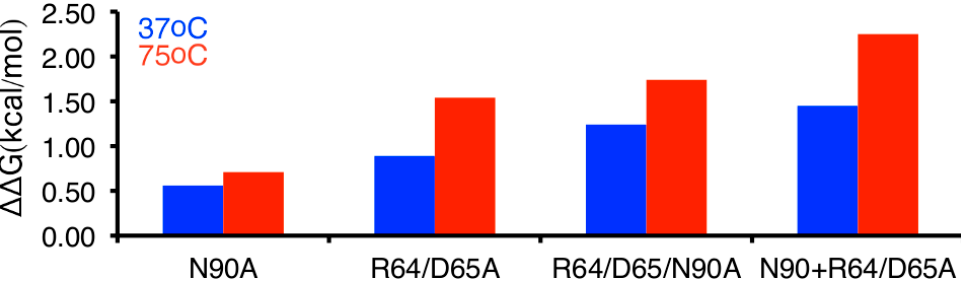
Figure 5. Catalytic efficiency free energy changes induced by disrupting β 1 α 1 loop interactions at 37 ◦ C (blue) and 75 ◦ C (red). ∆∆ G values were calculated according to: ∆∆ G = − RT (( k cat /K M ) variant /( k cat /K M ) WT .